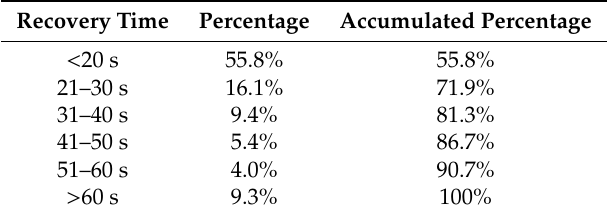
Table 4. Time required for full-vision recovery after glare exposition (total sample).